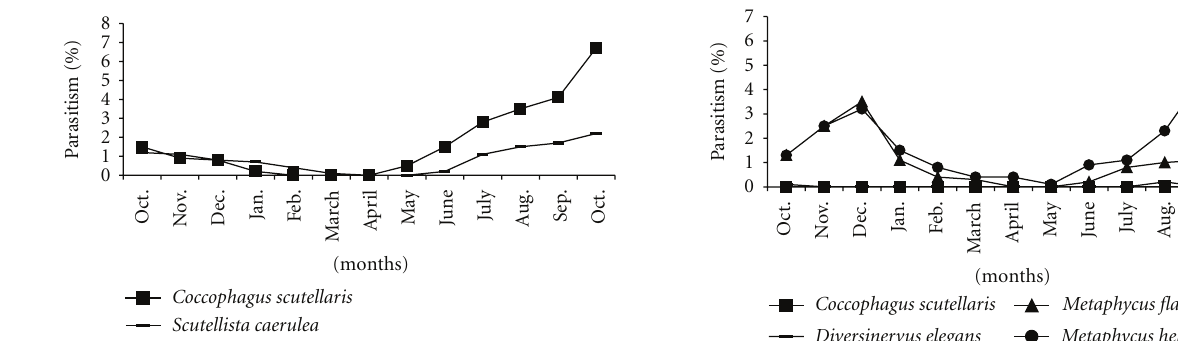
Figure 10: Percent parasitism of Coccophagus scutellaris and other associated parasitoids of Pulvinaria psidii on mango in Ismailia governorate before releasing during